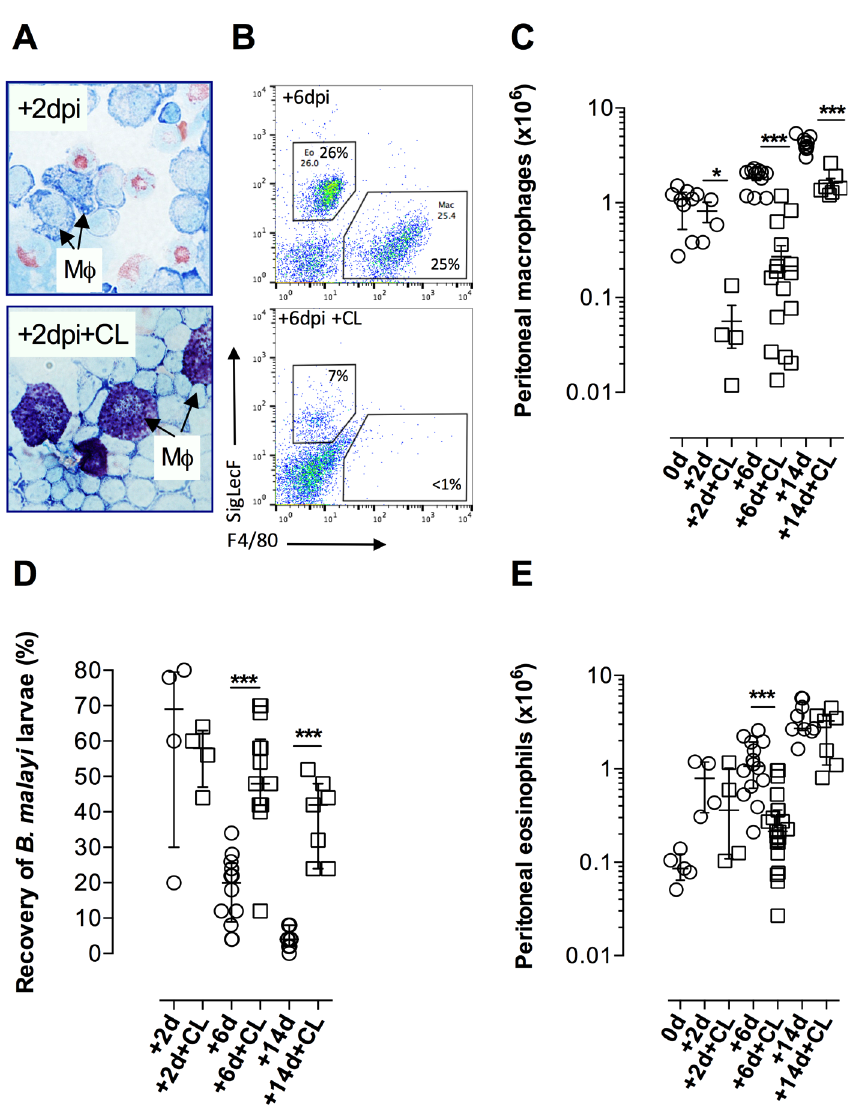
Fig 5. Temporal ablation of peritoneal M ϕ enhances survival of B . malayi larvae coincident with impaired tissue eosinophilia. Cytospins of peritoneal cells with macrophages (M ϕ ) indicated (A) , quantification of macrophages and eosinophils (B,C,E) and recovery of B . malayi larvae (D) at indicated time points post-infection with 50 B . malayi L3 with or without prior treatment with clodronate liposomes (CL) in BALB/c WT mice or naïve controls (d0). Data from individual mice with median and interquartile range are plotted. Significant differences between groups per time point assessed by Mann-Whitney. Data is from an individual experiment or pooled from 2–3 individual experiments per time-point using groups of 4–6 mice per group /